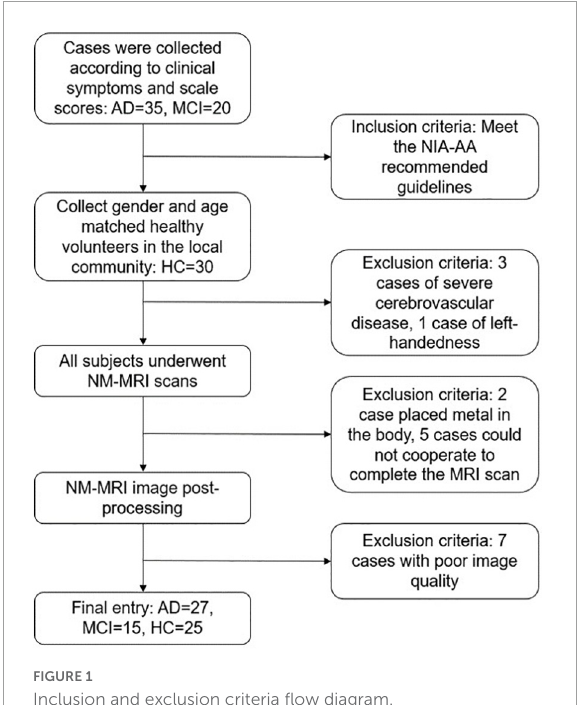
FIGURE1 Inclusion and exclusion criteria flow diagram.